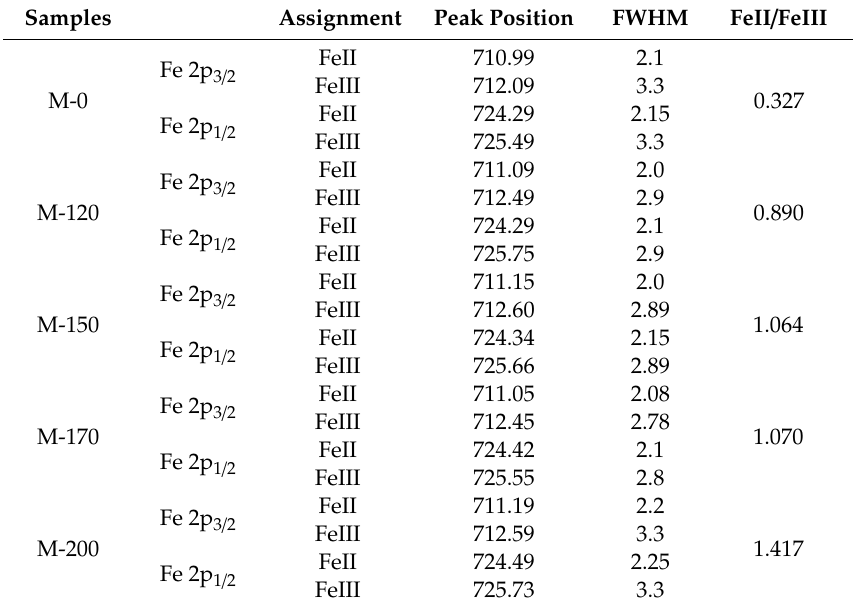
Table 1. Chemical states of Fe elements and the corresponding parameters.